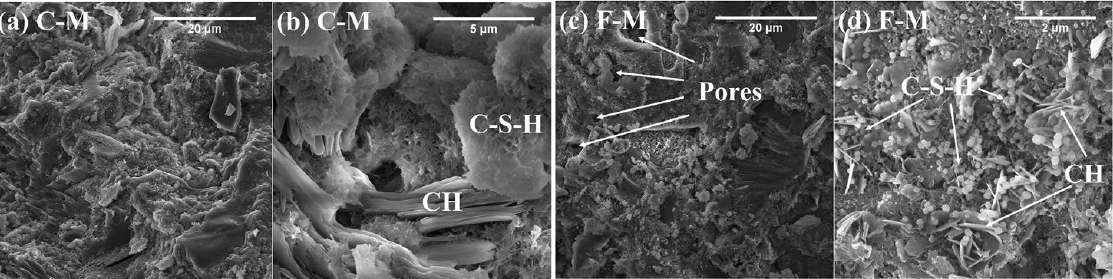
Figure 5. SEM images of the pastes (28 days). ( a ) The cement paste observed in a sacle of 20 μ m, ( b ) the enlarged figure of the cement paste (5 μ m), ( c ) the composite paste containing 20% EFS (20 μ m), and ( d ) the composite paste containing 20% EFS (2 μ m) [100].